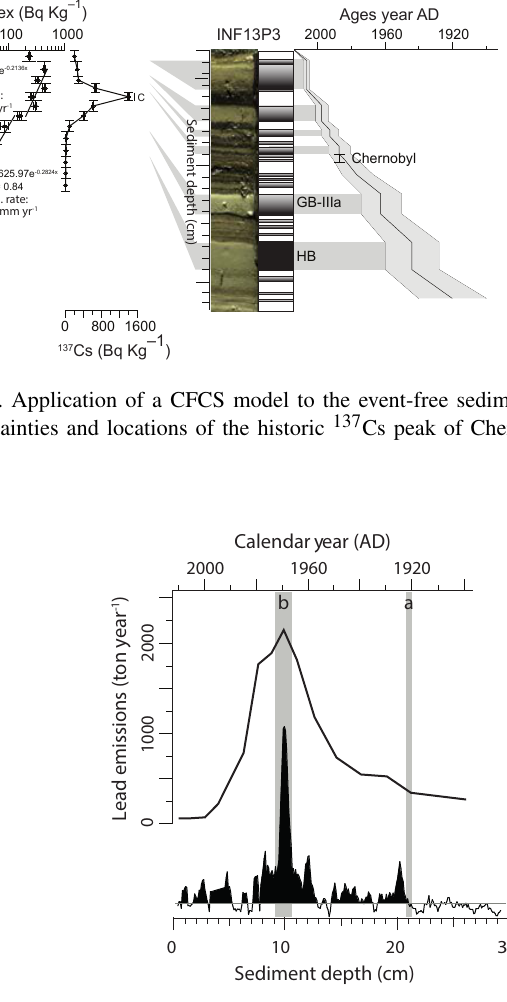
Figure 6. Historical lead (Pb) emissions in Switzerland (from Weiss et al., 1999) compared to the Pb / Ti ratio measured in core